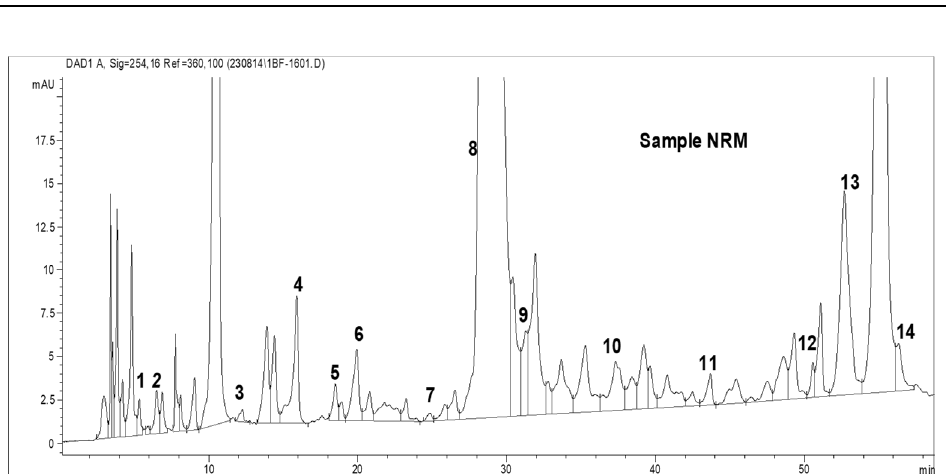
Figure 5. TAA content in R. palustris SMR 001 phototrophic bacteria determined by HPLC. Table 2. TAA content in the R. palustris strain determined by HPLC. Sl. No.